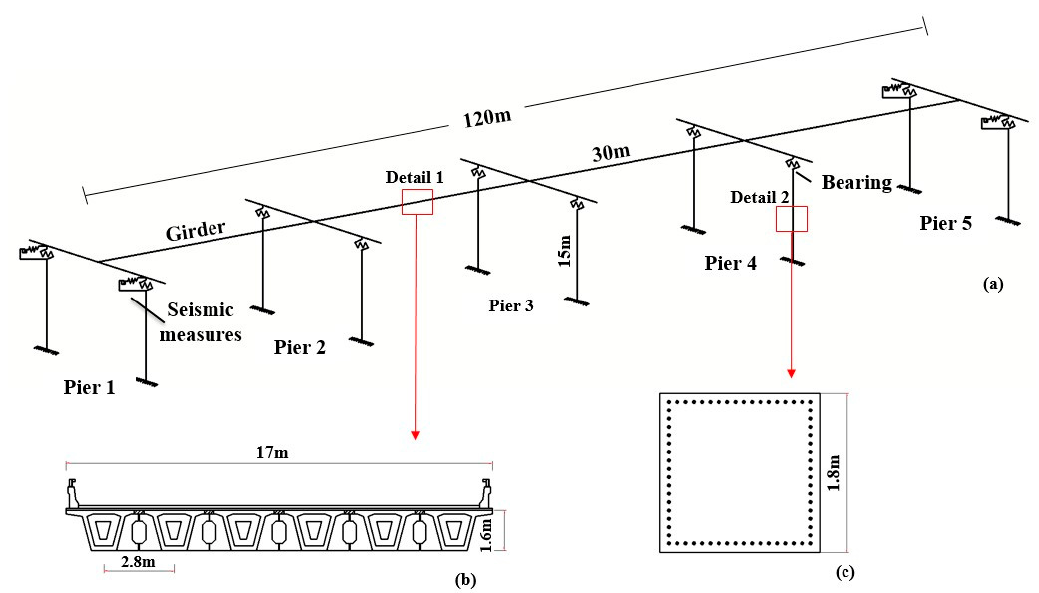
Figure 1. Finite-element model of bridge: ( a ) detail of bridge; ( b ) section of girder; ( c ) section of pier. The bearings adopted on #1 and #5 piers and #2, #3, and #4 piers are different. Slide rubber bearings are adopted on #1 and #5 piers, in order to satisfy the deformation requirements of the structure under a static load, whereas laminated rubber bearings are adopted on #2, #3, and #4 piers. The bearings consisting of an elastomeric rubber pad are modelled by the elastic, perfectly plastic element to represent the frictional force developed at the elastomeric pad. The parameters of the bearings are shown in Table 1 [36].